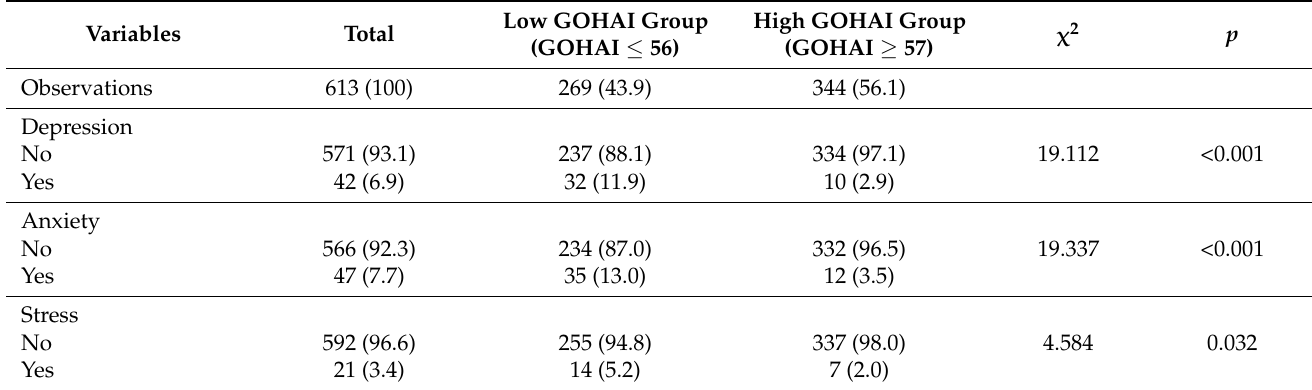
Table 3. Depression, anxiety, stress, and the GOHAI of the MEFC.